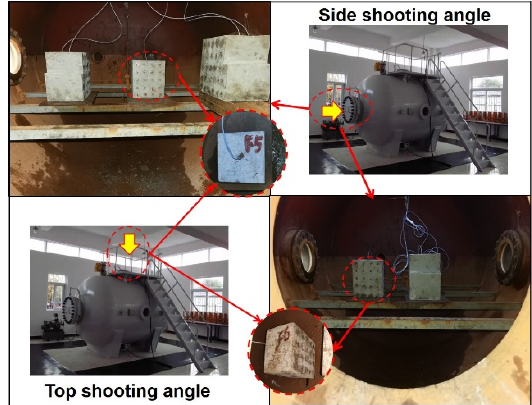
Figure 9. Specimen-placement photographs inside vessel.